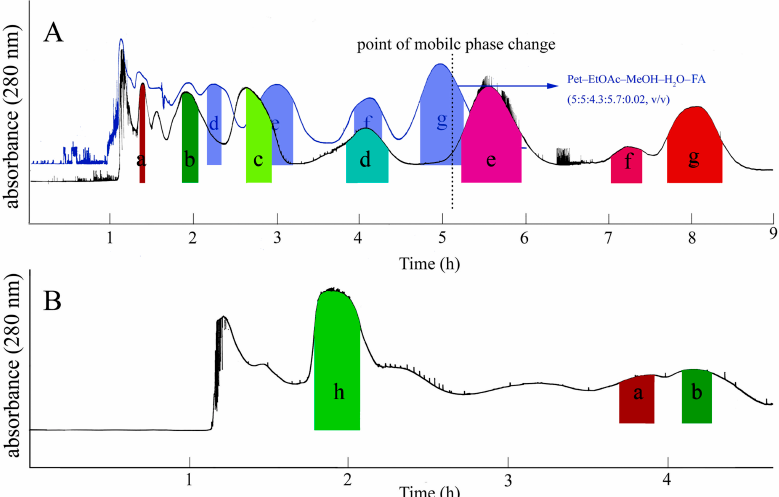
Figure 3. High-speed counter-current chromatography (HSCCC) Chromatograms of part I and part II. ( A ) Experimental conditions of part I: the black line HSCCC Chromatogram: solvent